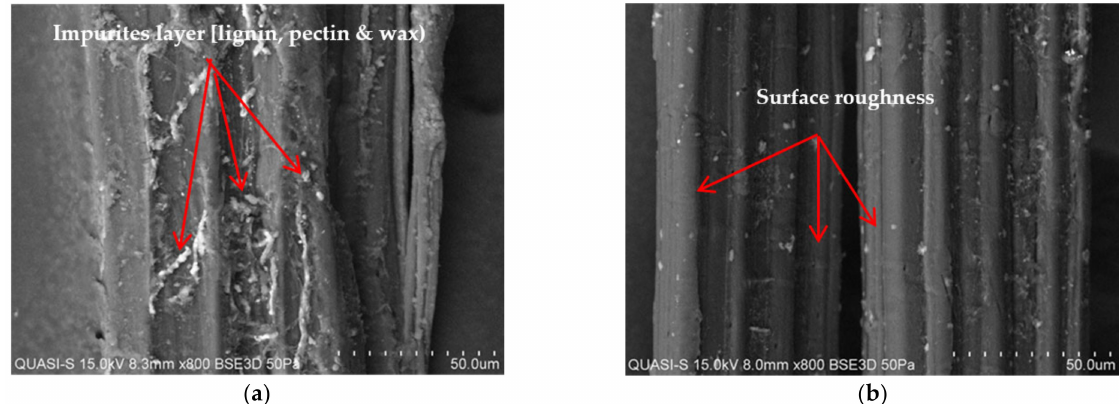
Figure 7. SEM images from longitudinal views for kenaf fibers; ( a ) untreated kenaf fiber; ( b ) treated kenaf